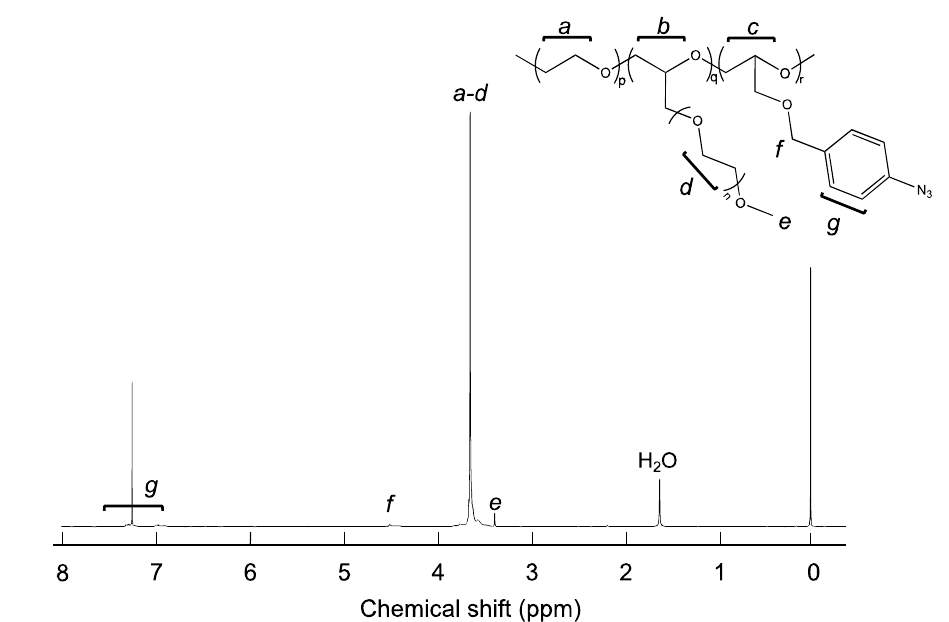
Figure 1. 1 H NMR spectrum of AzPEG750 [5] (solvent: chloroform–d). The UV absorbance spectrum of AzPEG750 [5] and 4-azidobenzoic acid is presented in Figure 2. The peak of the azidophenyl group slightly shifted to a lower wavelength. The azidophenyl group was considered to be in the hydrophobic region of the polymer.